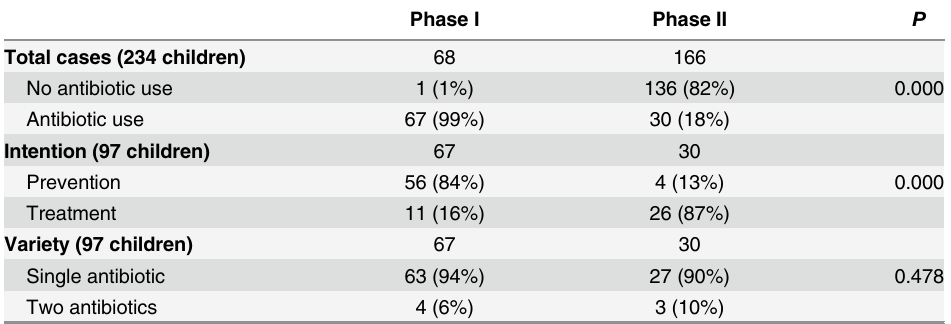
Table 1. Antibiotic comparisons in children with intussusception after air enema reduction in two phases